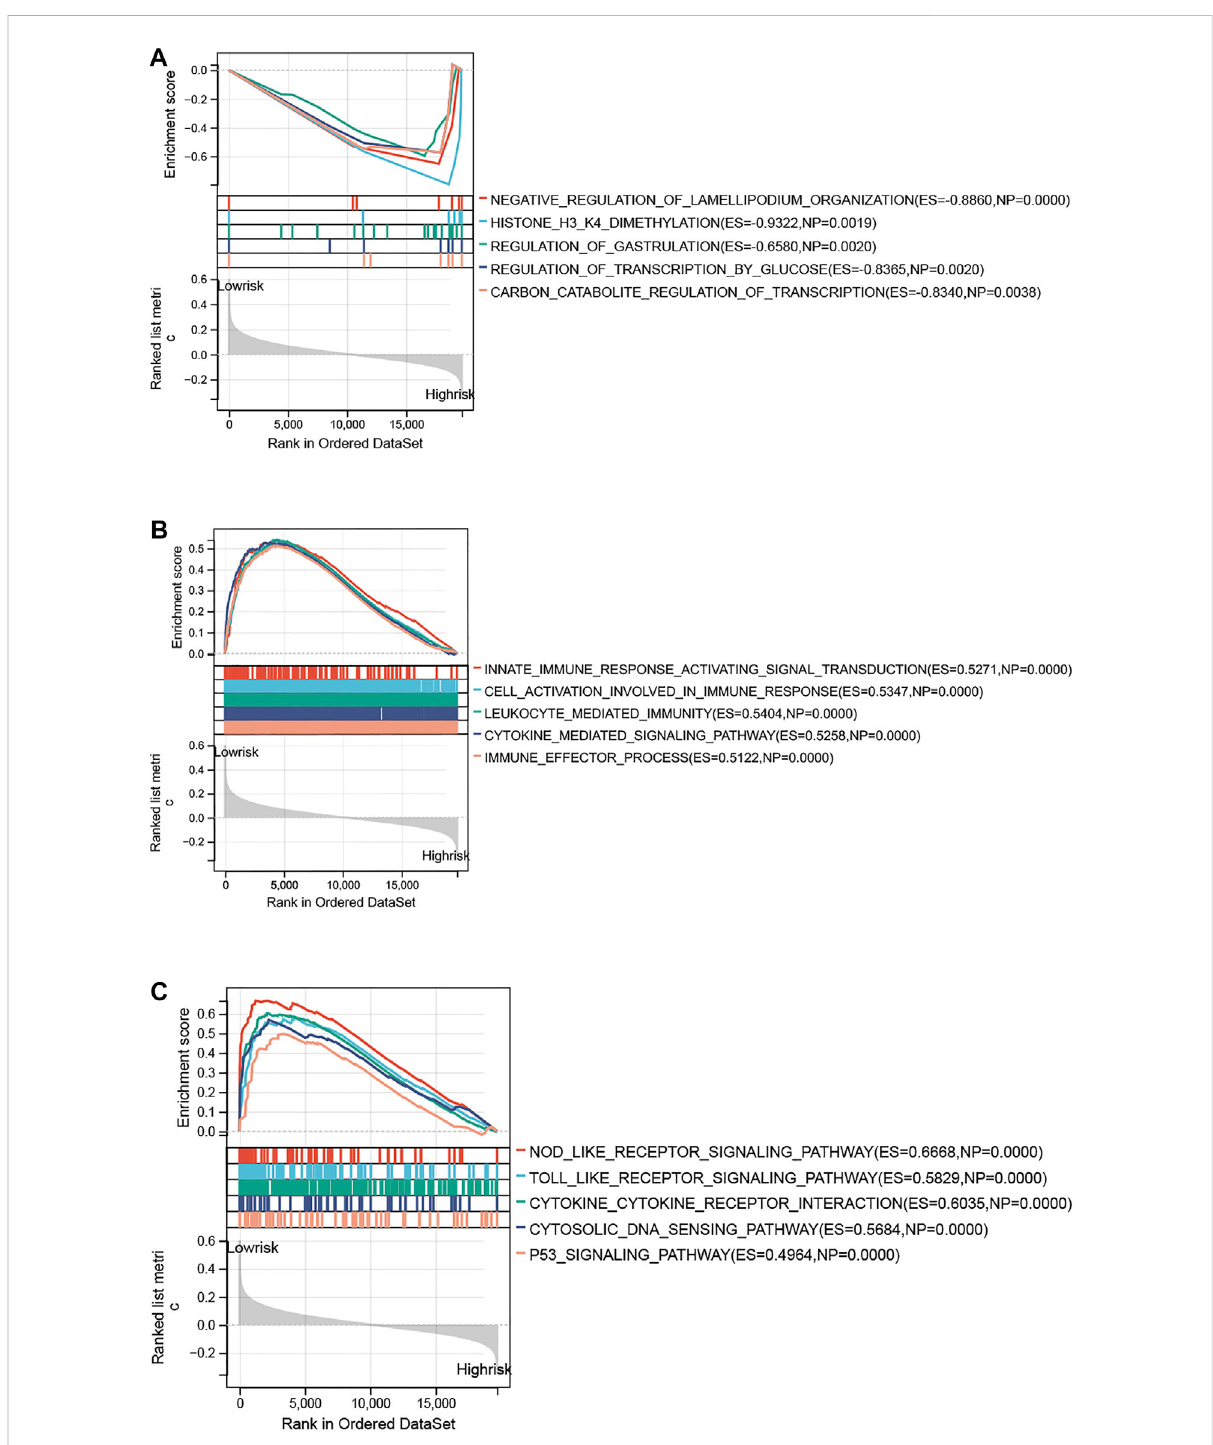
FIGURE 7 Functional enrichment analysis between high- and low-risk groups. (A) Top 5 GO terms enriched in the high-risk group. (B) Top 5 GO terms enriched in the low-risk group. (C) Top 5 KEGG terms enriched in the low-risk